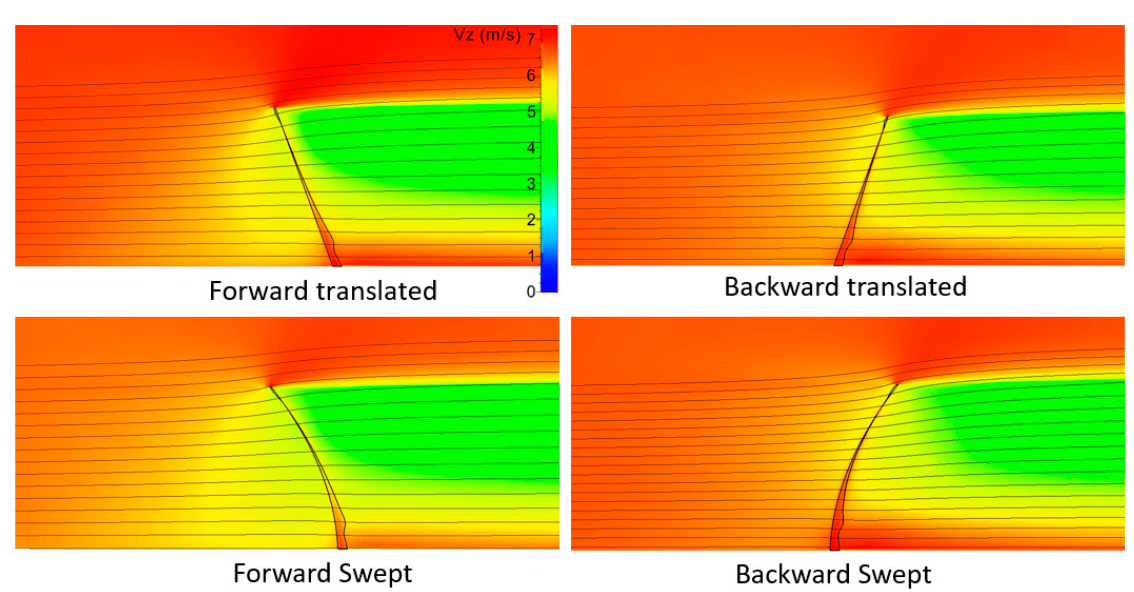
Figure 37. Axial velocity in axisymmetric view for different sweep and translation definitions.